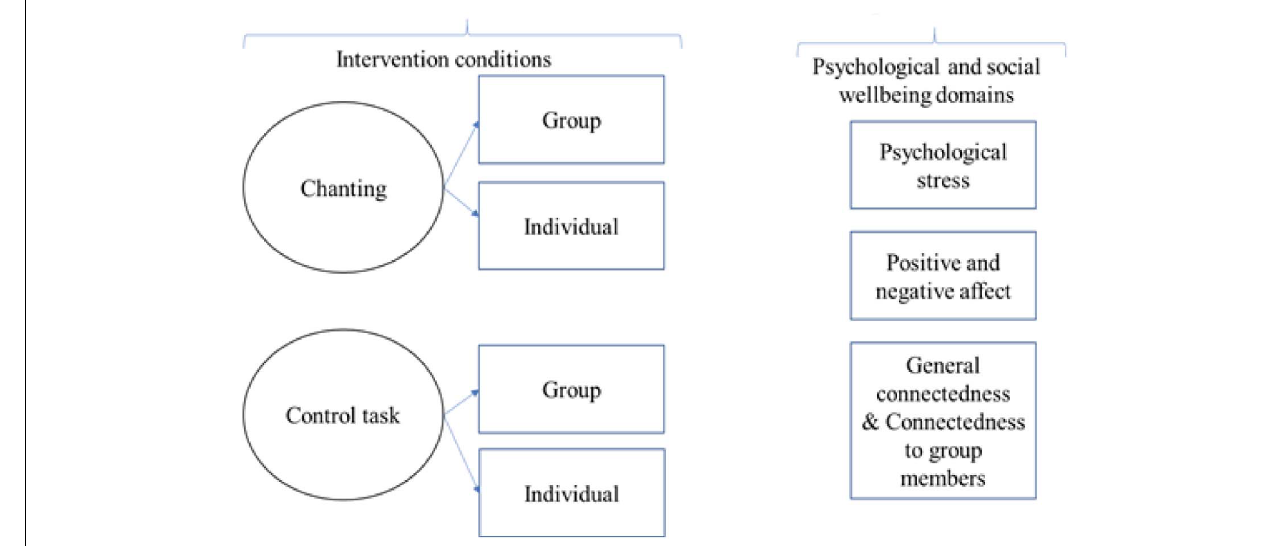
FIGURE 2 | Illustration of the study